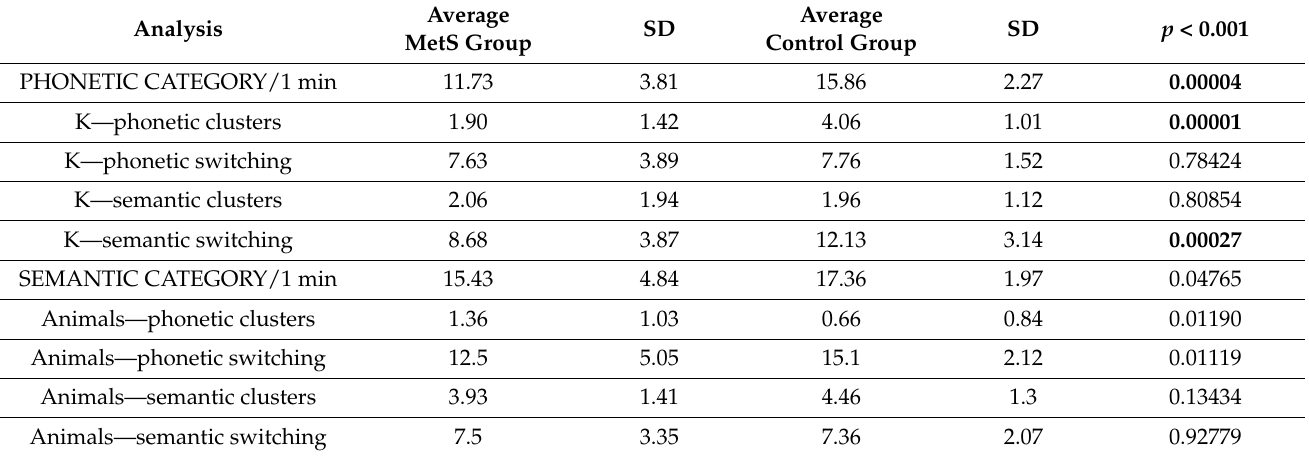
Table 3. Difference in the results of verbal fluency amongst people with metabolic syndrome and